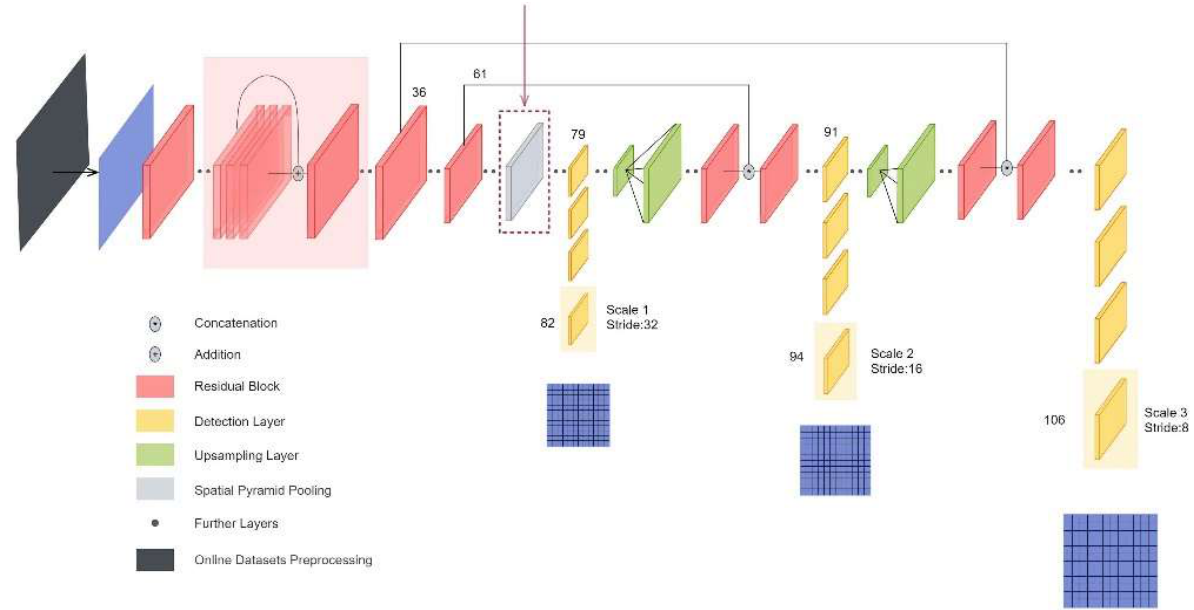
Figure 8. The model of Online Datasets preprocessing with YOLO V3 + SPP. Algorithm 7 : Online Datasets Preprocessing YOLO V3 + SPP Algorithm